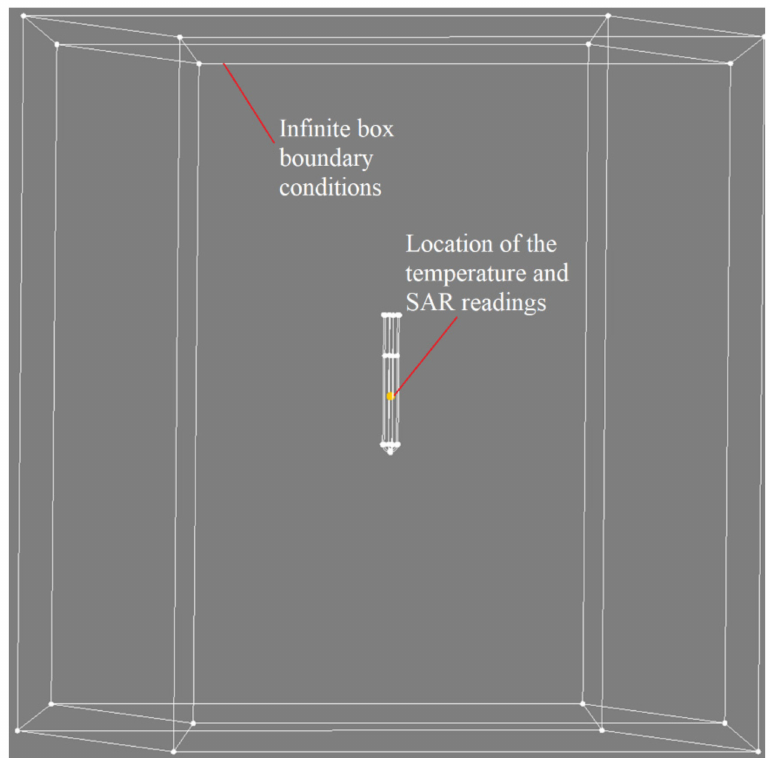
Figure 5. Location of the temperature and Specific Absorption Rate (SAR) readings and Infinite box boundary